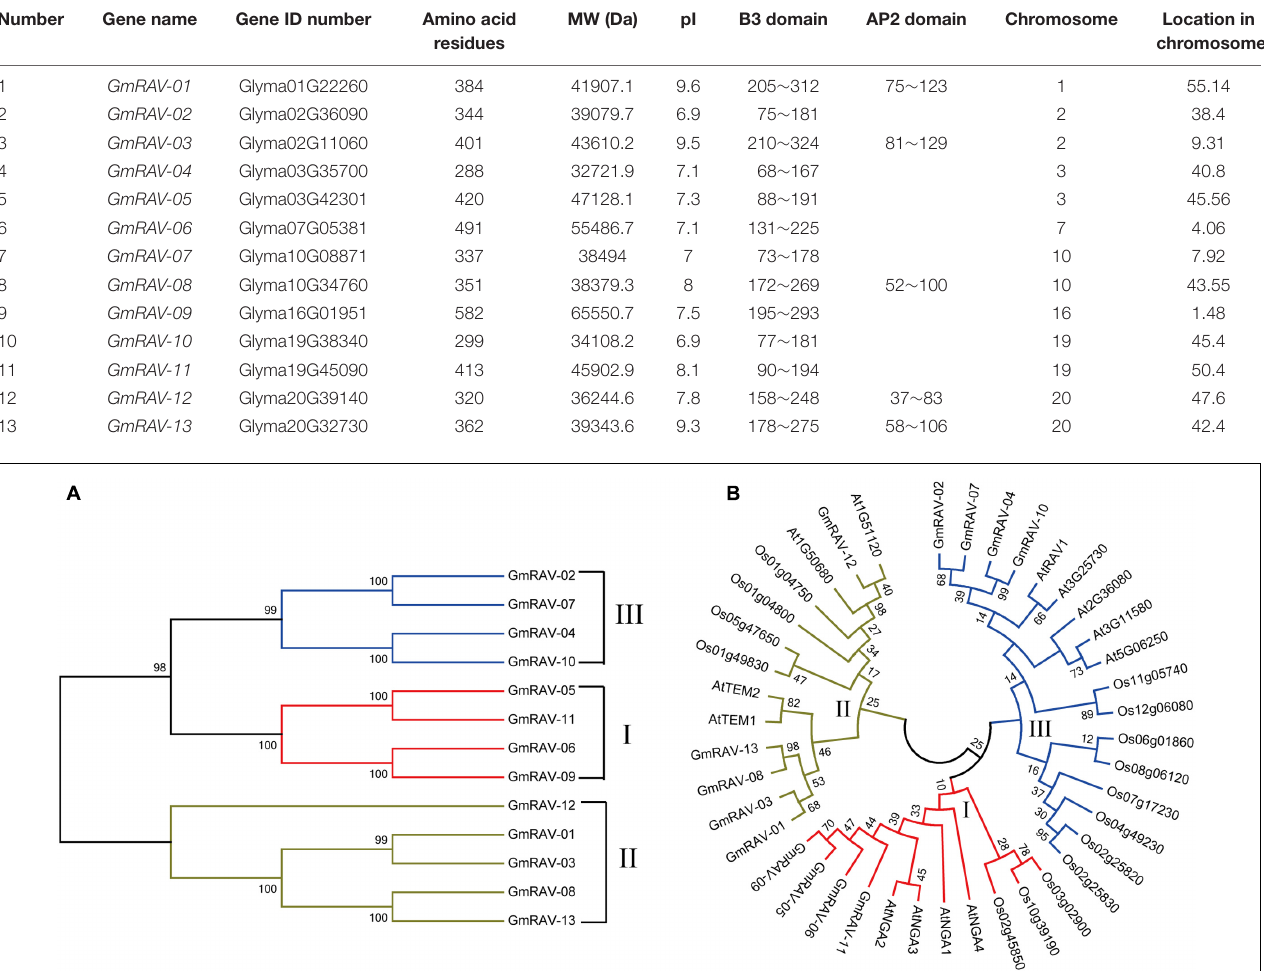
FIGURE 1 | Phylogenetic relationships of RAV family proteins in soybean, Arabidopsis, and rice. The phylogenetic tree was produced using MEGA 7.0 software based on the comparison of amino acid sequences of the RAV proteins. The neighbor-joining method was used and the bootstrap replicates were set at 1000. (A) Neighbor-joining phylogenetic tree of the RAV family in soybean. (B) Phylogenetic relationship of the RAV families of Gm ( Glycine max ), At ( Arabidopsis thaliana ), and Os ( Oryza sativa ). Soybean RAVs were divided into three classes (I, II, III).